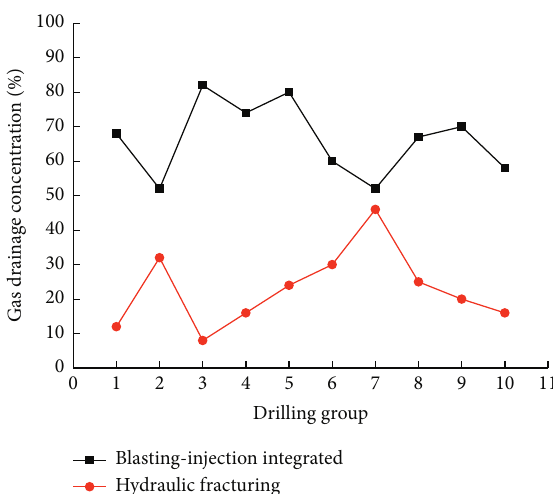
Figure 12: Comparison curve of gas drainage concentration before and after blasting-injection integrated antireflection technology.